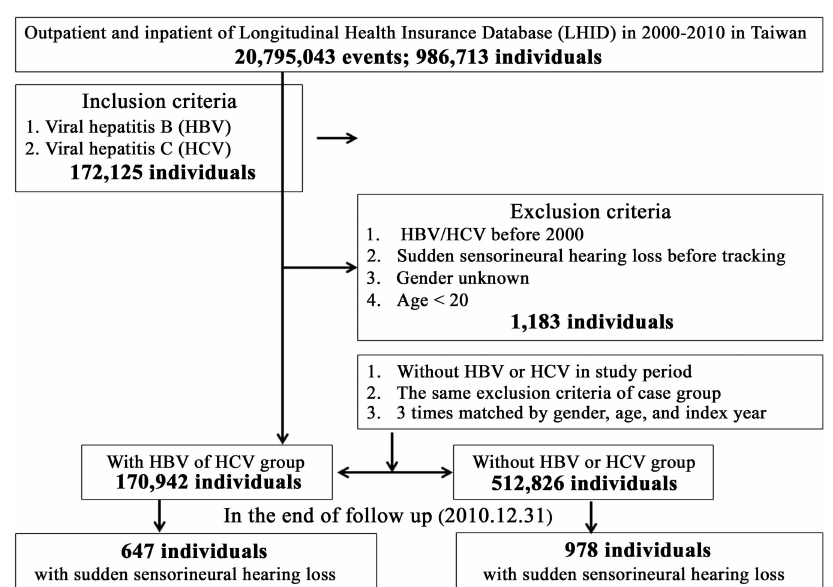
Fig 1. Flowchart of study sample selection from the National Health Insurance Research Databasein